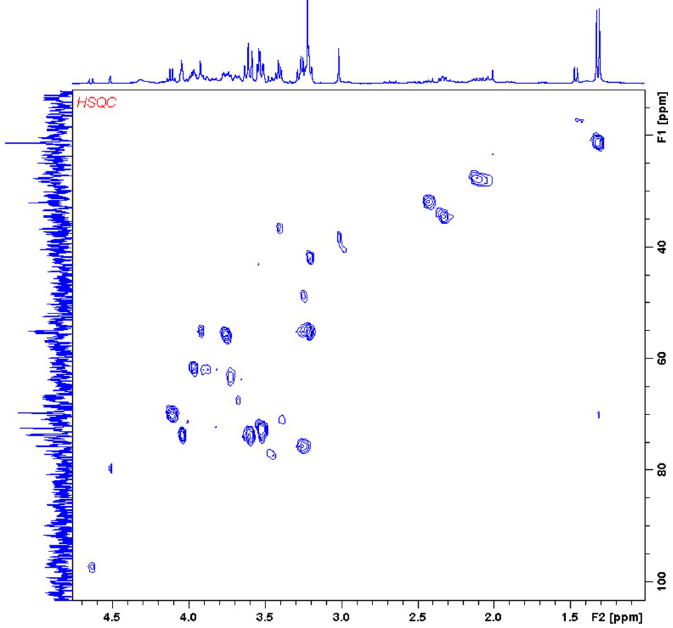
Fig 1. 2D 1 H- 13 C HSQC spectrum. Representative example from an AGA brain sample corresponding to the ACE group. Reference spectra displayed in the horizontal axis ( 1 H CPMG) and vertical axis ( 1 H-decoupled 13 C),